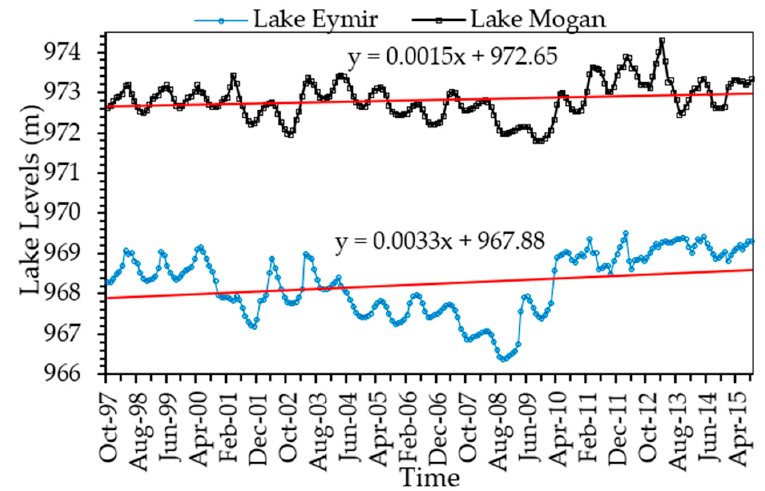
Figure 10. Time series and linear trend analyses of lake levels between 1997 and 2015.